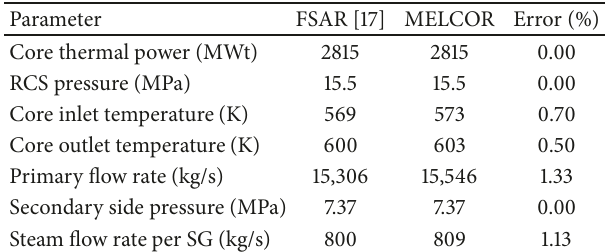
Figure 4: A schematic of the steam generator tube rupture in MELCOR input model. Table1:ComparisonofmajorparametersbetweenFSARvaluesand MELCOR calculation.